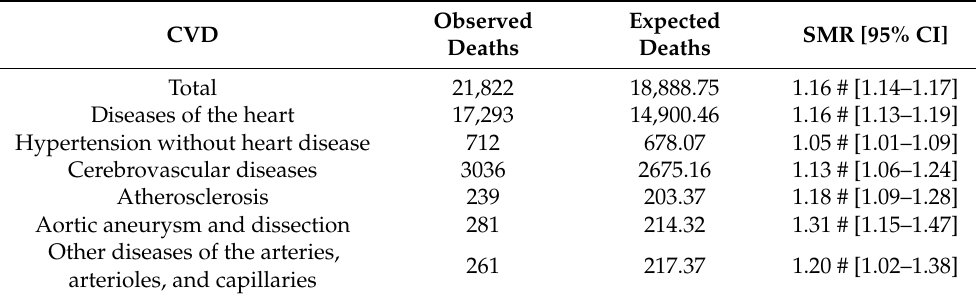
Table 2. The standardized mortality ratios of all causes of cardiovascular mortality in patients with bladder